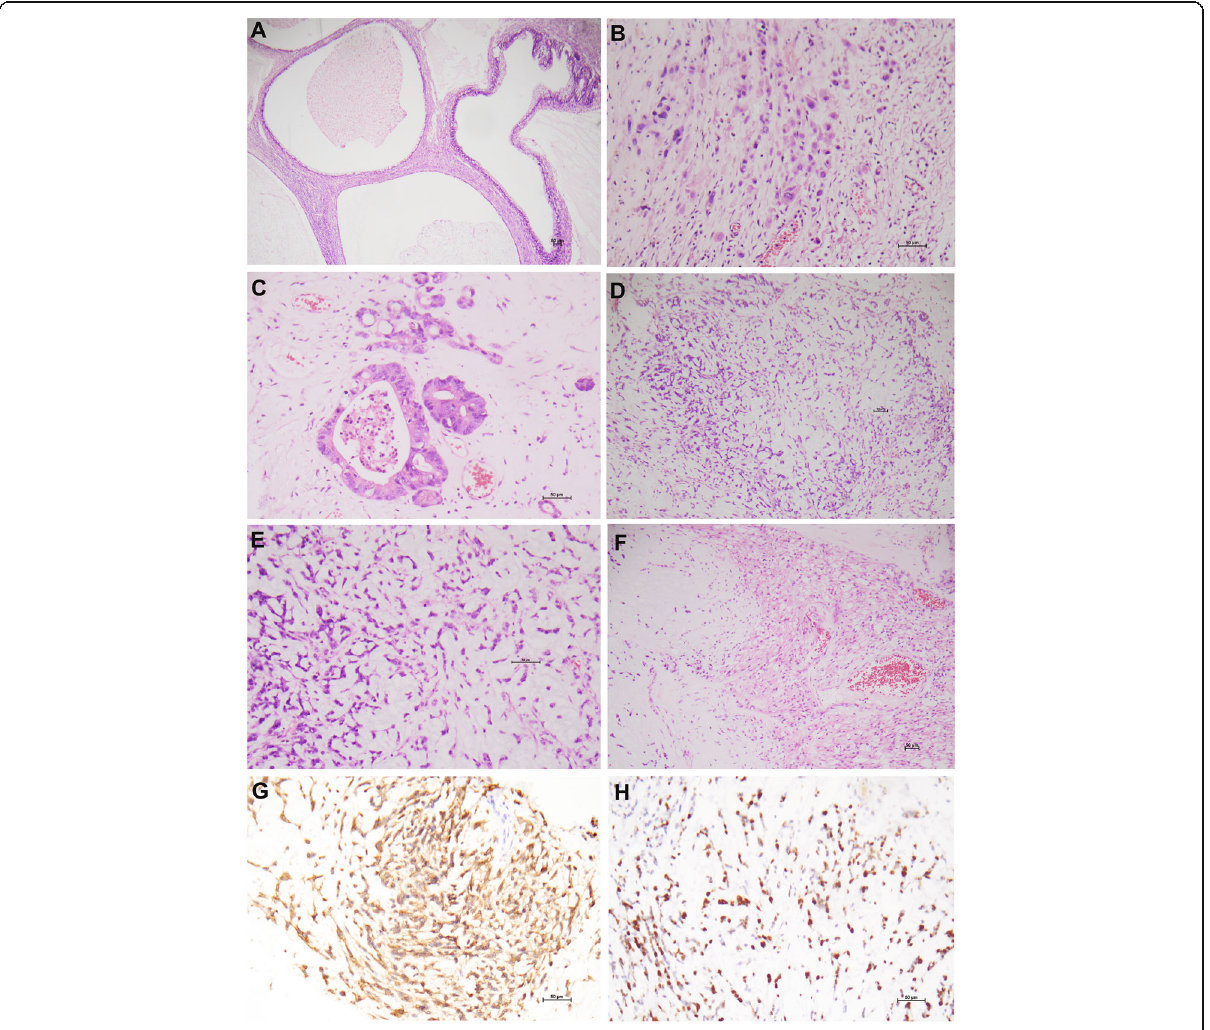
Fig. 2 Ovarian mucinous tumor with sarcomatous mural nodules (patient 2). The adenofibromatous areas contain atypical intestinal-type mucinous glands with stratification in keeping with a borderline tumor [ a ]. The invasive lesions are characterized by dyscohesive atypical cells [ b ] and atypical mucinous glands admixed with the myxoid components [ c ]. The mural nodules are composed of uniform short spindle cells separated by abundant myxoid matrix [ d ]. The hyperchromatic tumor cells harbor a high nuclear-cytoplasmic ratio [ e ]. Focal spindle cells with esinophilic cytoplasm arranged in fascicles were suggestive of smooth muscle differentiation [ f ]. The neoplastic cells in the mural nodules are CD10+ [ g ] and have a high Ki-67 index [H]. (H&E: a × 5, b , c & e × 200, d & f × 100; immunohistochemistry, g & h ×